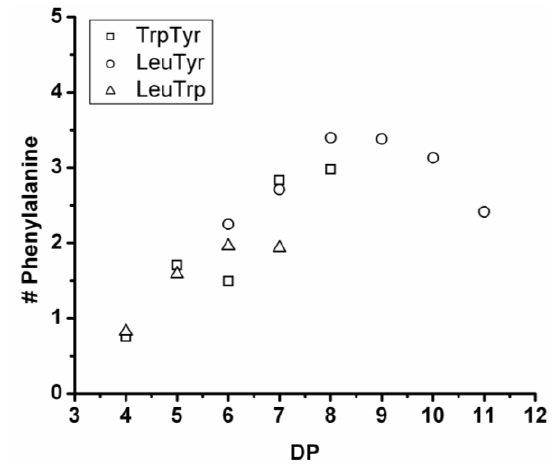
Figure 30. Average amount of phenylalanine in ternary co-oligo amino